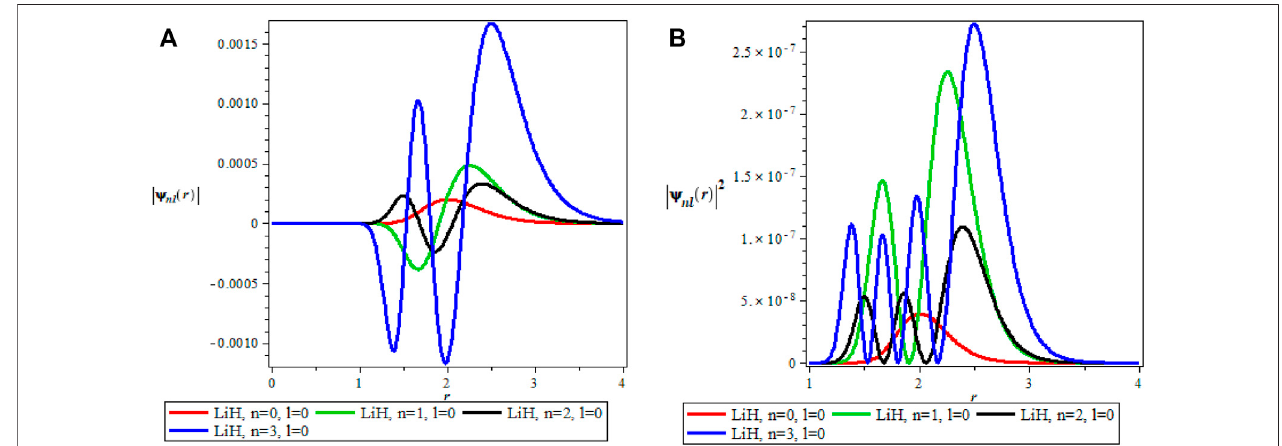
FIGURE 1 | (A) Wavefunction plot for fi xed l = 0 for LiH molecule. (B) Probabilty density plot for fi xed l = 0 for LiH molecule.